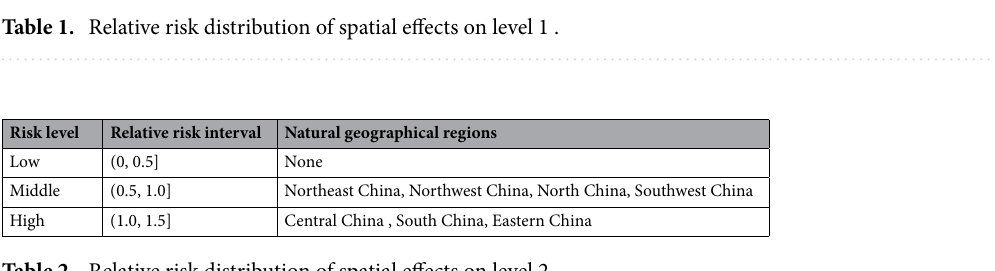
Table 2. Relative risk distribution of spatial effects on level 2.